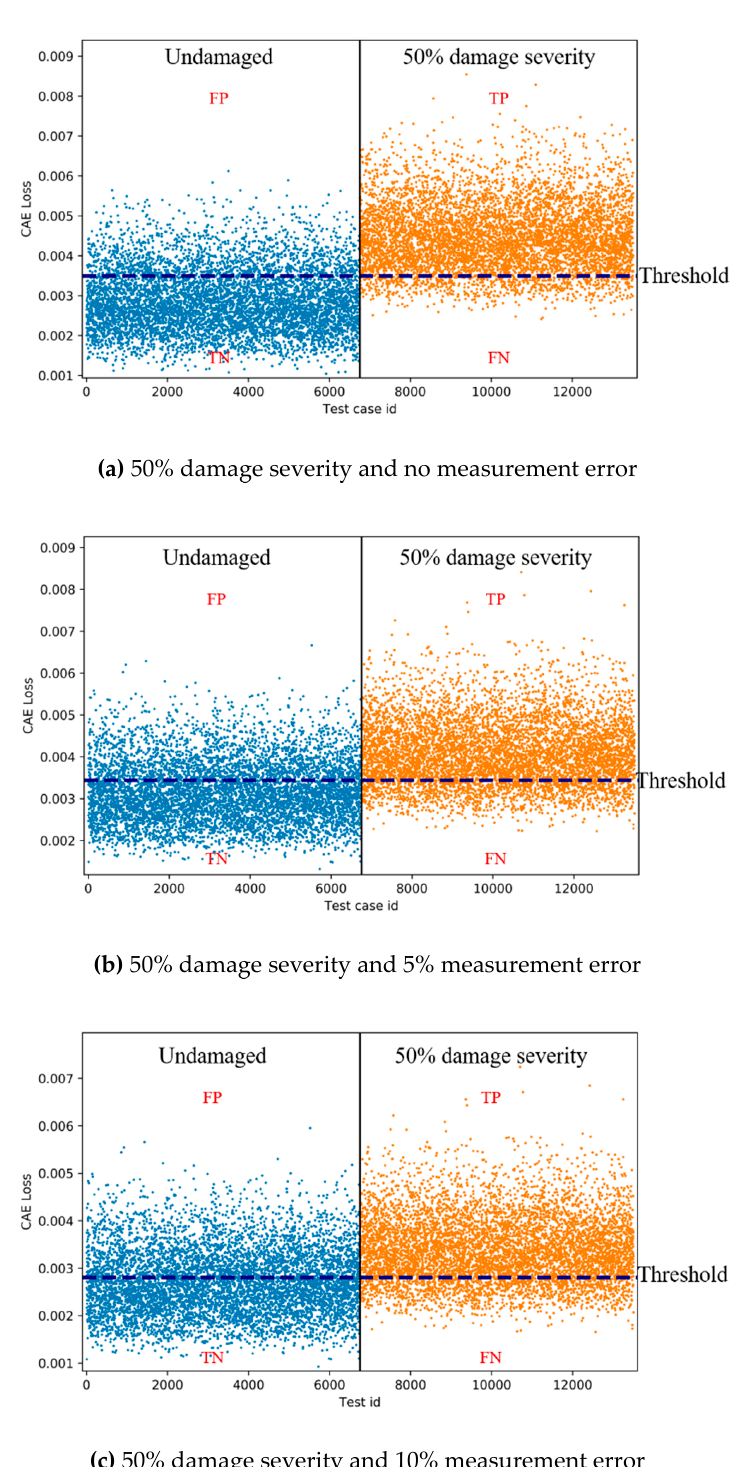
Figure 10. Examples of CAE losses of test data from both undamaged and damaged states for multi- vehicle traffic loads (TP indicates true and positive. FP indicates false and positive. TN indicates true and negative. FN indicates false and negative. True means that the CAE correctly detected the state of bridge. False means that the CAE incorrectly detected the state of bridge. Positive means that the predicted state is the damaged state. Negative means that the predicted state is the undamaged state.).